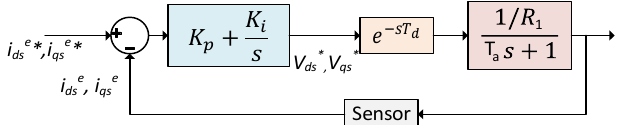
Figure 8. Feedback current control loop.